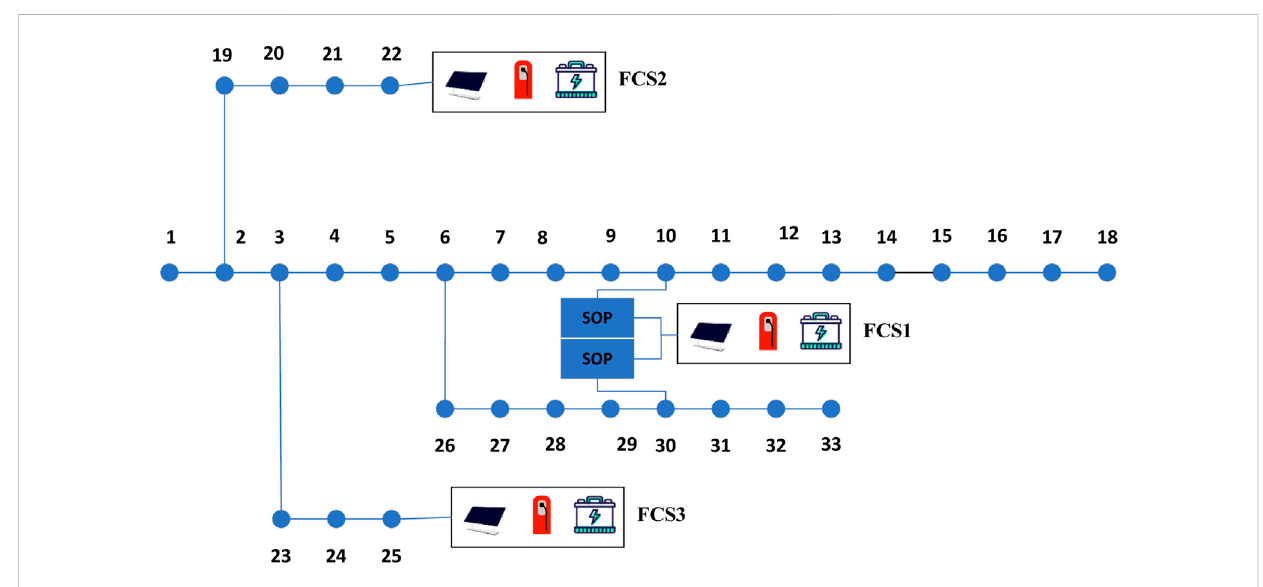
FIGURE 4 Topological structure of distribution